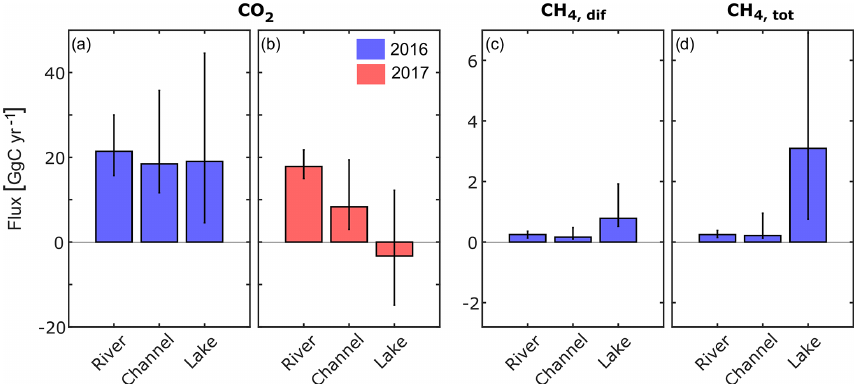
Figure 6. Annual greenhouse gas fluxes to the atmosphere obtained by upscaling the monthly median flux to the total area of each waterscape and taking the sum over all months (see text for details). Black vertical lines indicate the uncertainty and were calculated using the 25 percentile and 75 percentile, respectively, instead of median values for the calculation. CO 2 flux in panels (a) 2016 and (b) 2017. (c) Diffusive and (d) total CH 4 flux in 2016. Due to large data gaps, this calculation was not done for CH 4 in 2017. All fluxes are in GgCyr − 1 . For tabulated values, see Table